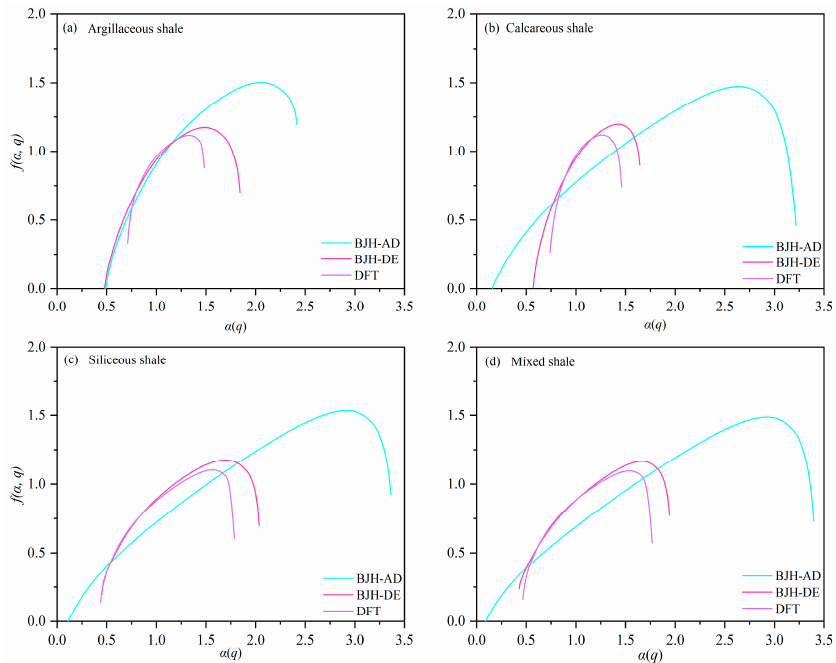
Figure 8. Multifractal singularity spectra of different BJH and DFT models obtained from the N 2 adsorption experiments. ( a ) f ( α , q ) of argillaceous shale; ( b ) f ( α , q ) of calcareous shale; ( c ) f ( α , q ) of siliceous shale; ( d ) f ( α , q ) of mixed shale.